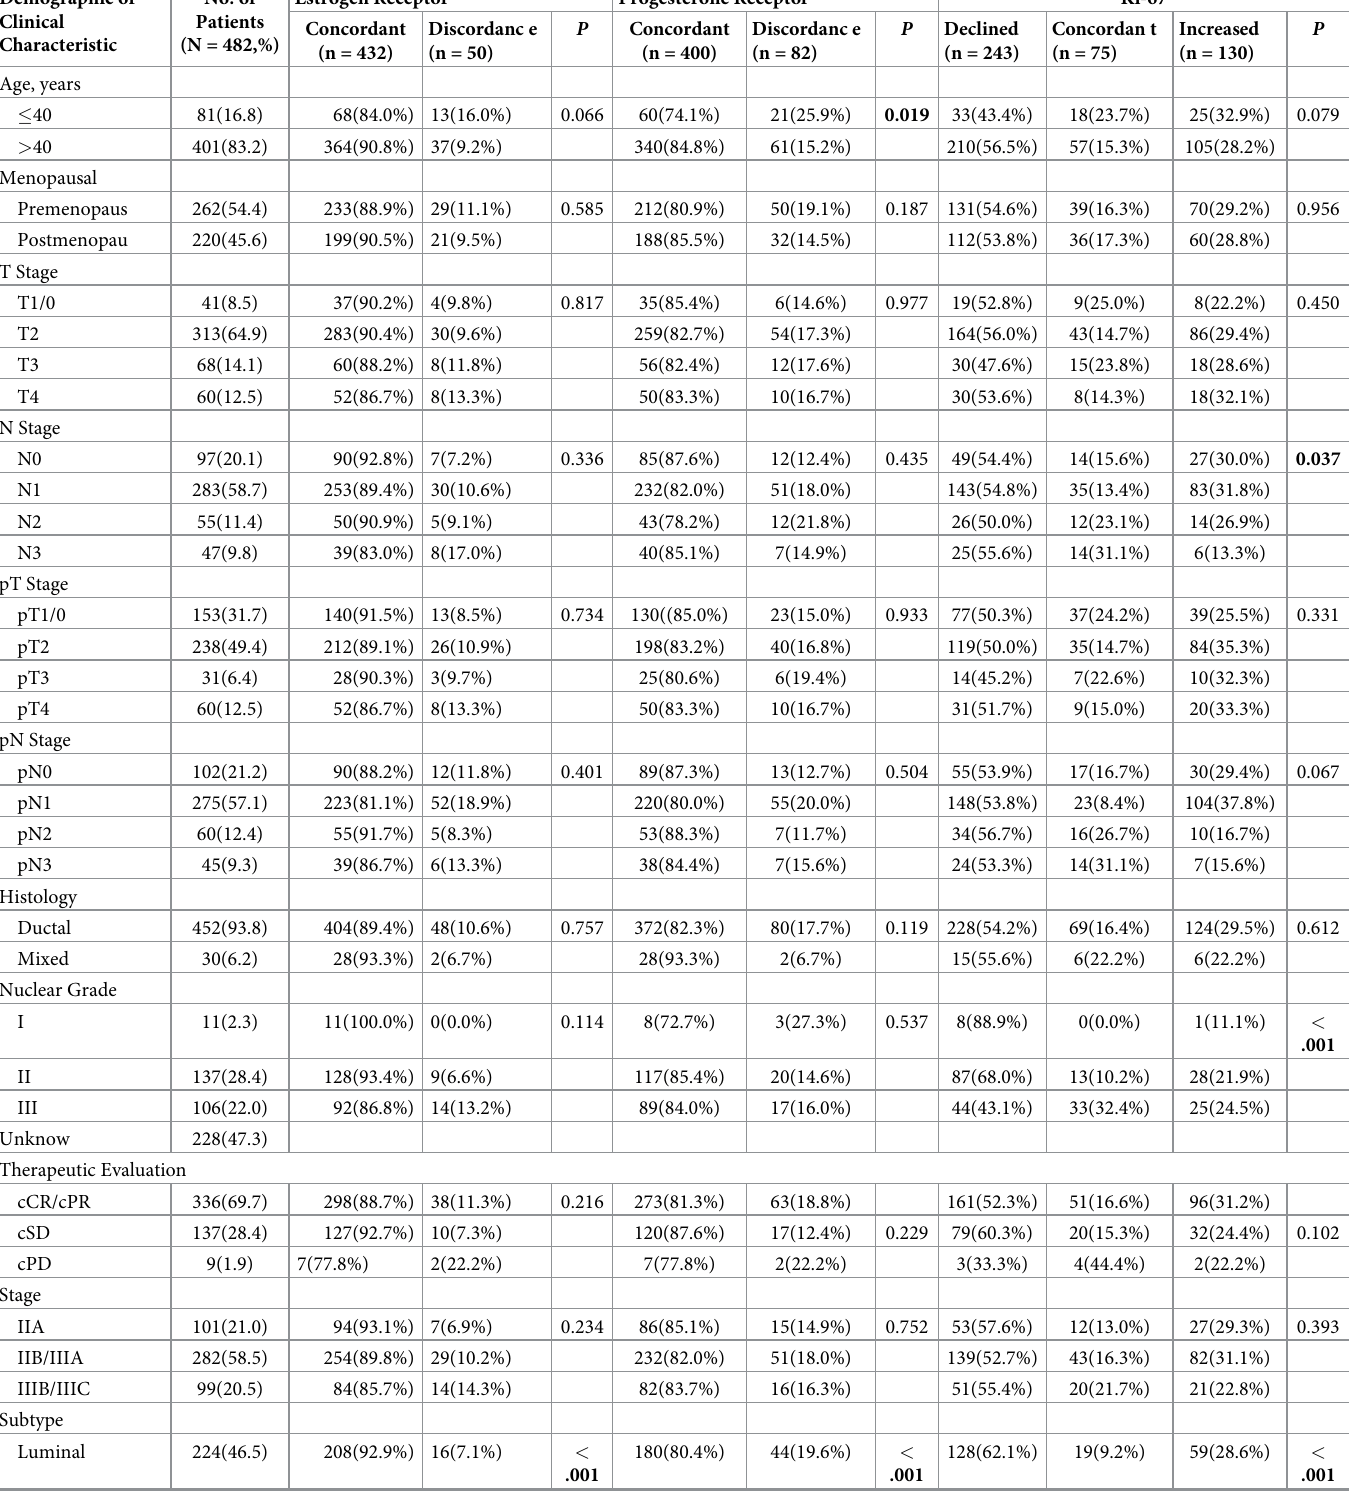
Table 1. The relationship between pathological characteristics and discordance of biomarkers. [N (%)]. Demographic or Clinical